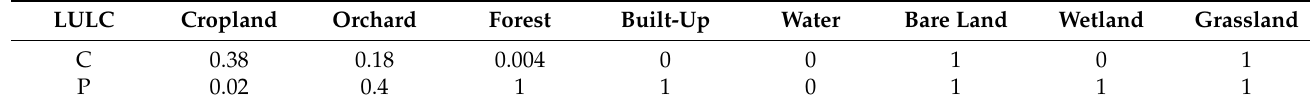
Table 2. The C and P values in different LULC of Shenzhen. LULC Cropland Orchard Forest Built-Up Water Bare Land Wetland Grassland